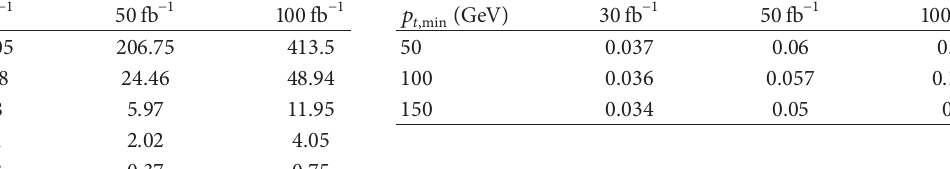
analysis. Here, 𝑝 𝑡, min transverse momentum cuts ( 𝑝 𝑡, min ) are taken to be 50 , 100 , and 150 GeV, respectively.